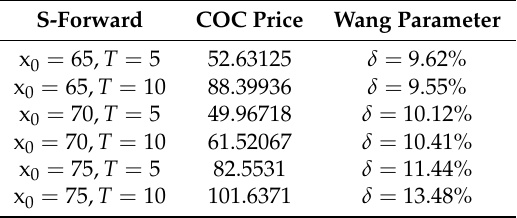
Table 10. Equivalent Wang parameters, HW